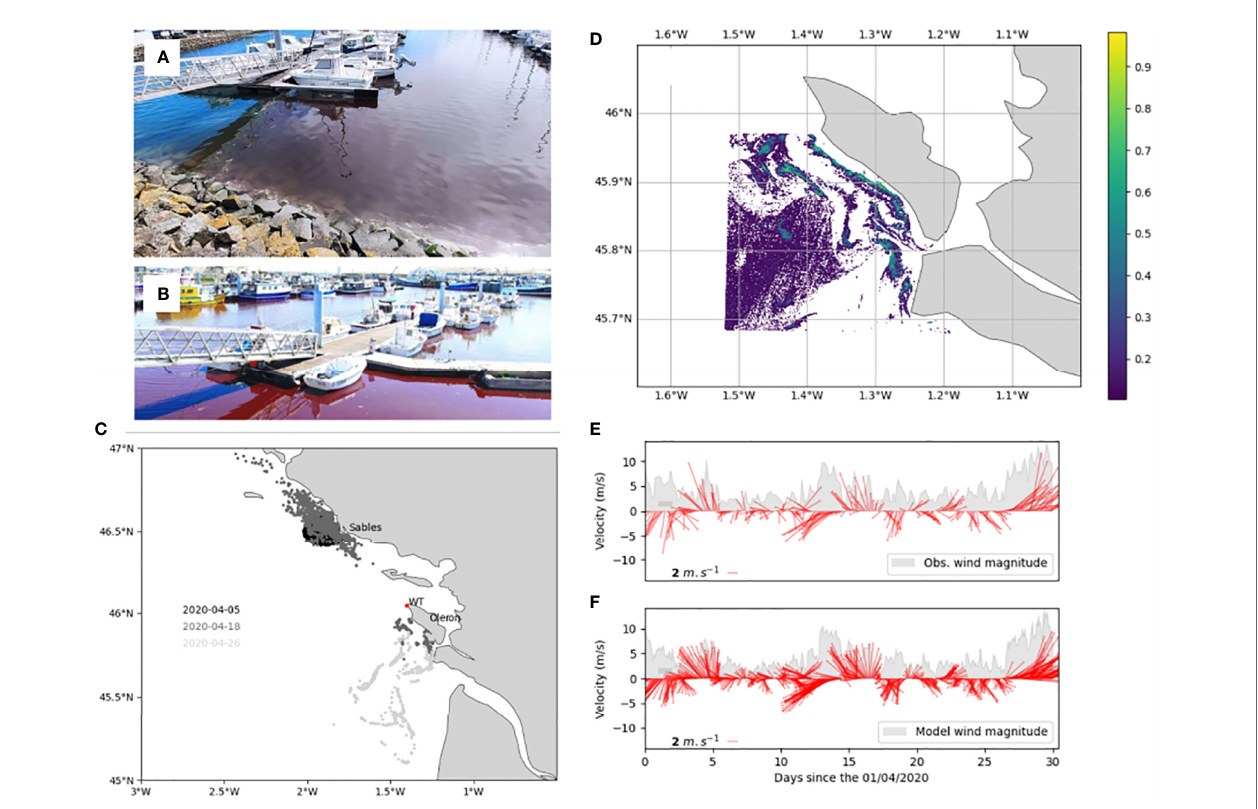
FIGURE 5 | Mesodinium rubrum observed in the harbours at Sables (A) and Oleron (B) on 05/04/2020 and 11/04/2020 respectively. The simulated advection (C) from each of these start locations and dates is shown. The fi rst release was from a point source in front of the Sables d ’ Olonne harbour (05/04) to see if there was a connective pathway between the events, and the second release (18/04 10:56) was based on a satellite index of bloom (D) Observed winds from the meteorological station Chassiron (WT) [10 min average, (E) ] are compared to forcing winds [minute frequency, (F) ] for the same location. Forcing winds were interpolated from ARPEGE-HR solutions (hourly